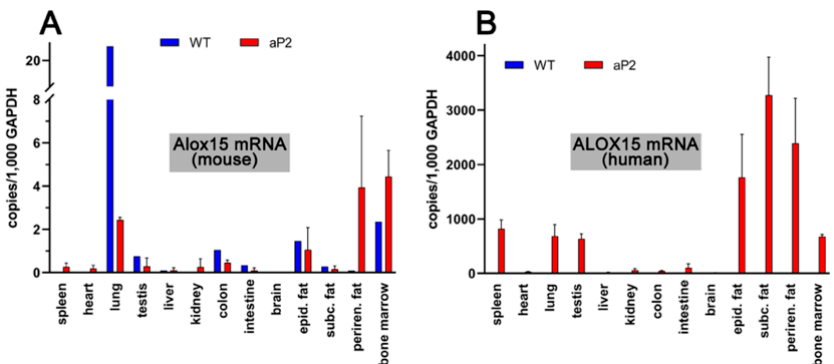
Figure 3. Expression of ALOX15 orthologs in different tissues of transgenic aP2-ALOX15 mice and wildtype controls (C57BL/6). ( A ) Amplification of endogenous mouse Alox15 mRNA. ( B ) Amplifi- cation of transgenic human ALOX15 mRNA. Ortholog specific primer combinations were used for these analyses; the sequences of these DNA primers are described in detail in Section 4.